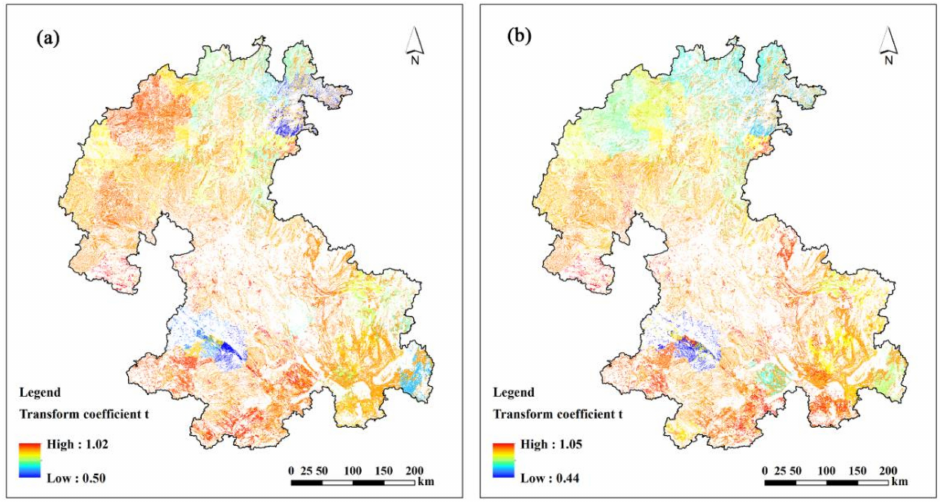
Figure 4. ( a ) The mixed transform coe ffi cient t in 2000; ( b ) The mixed transform coe ffi cient t in 2015.